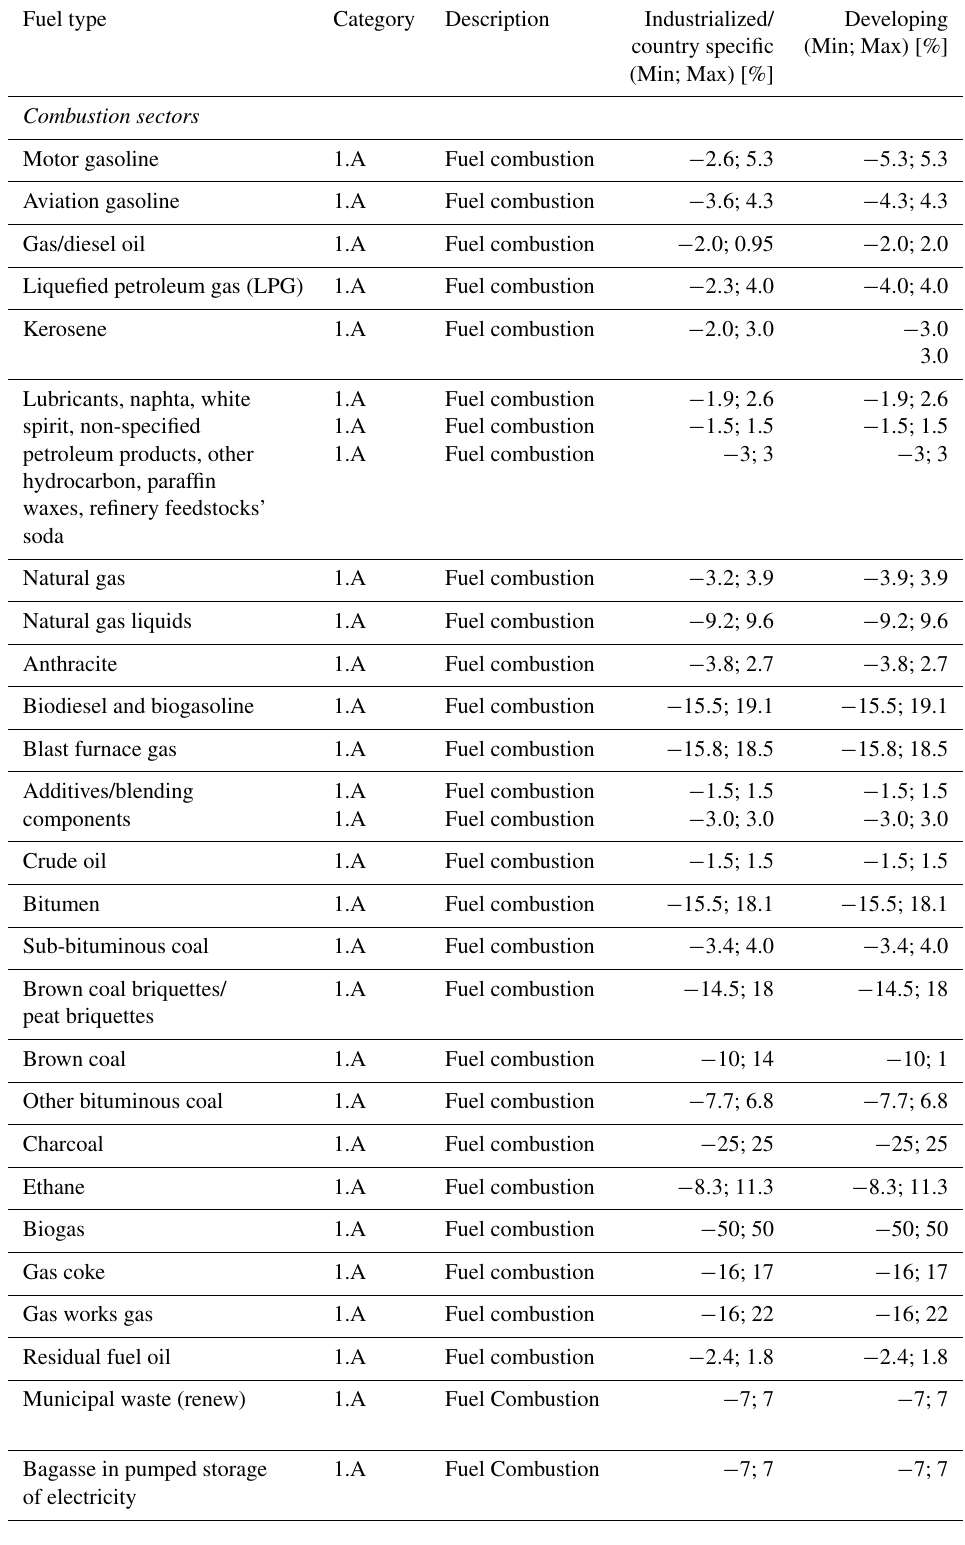
Table 2. CO 2 uncertainty in the emission factors (EFs) by fuel type (from Table 3.2.1 of IPCC,